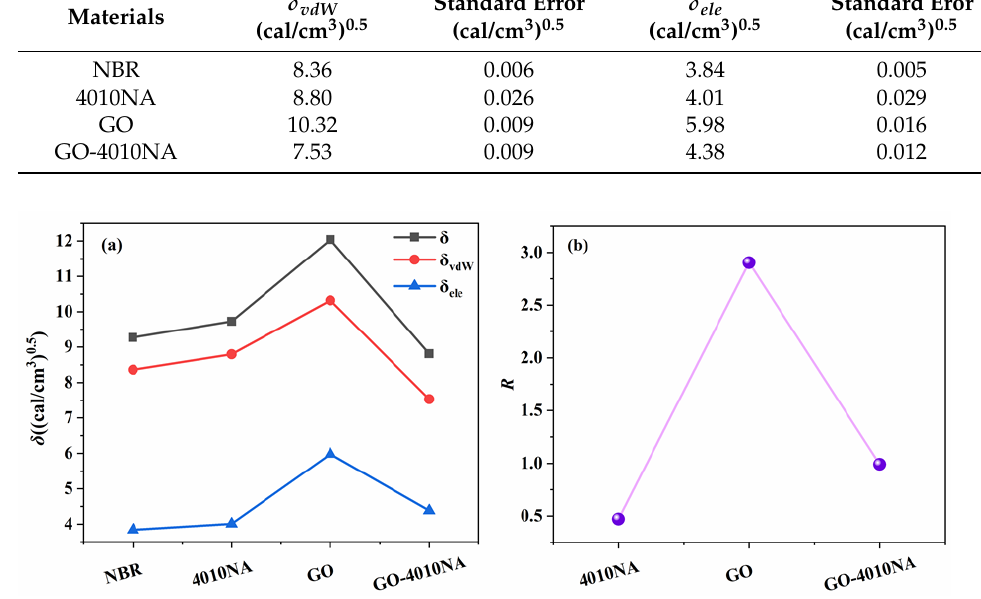
Figure 9. ( a ) Solubility parameter of NBR, 4010NA, GO, and GO-4010NA. ( b ) R value of NBR, 4010NA, GO, and GO-4010NA.